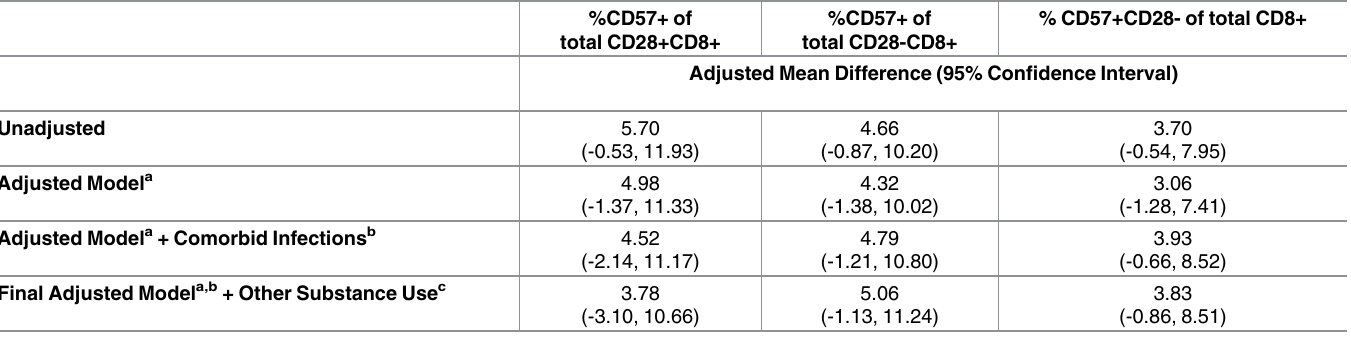
Table 5. Association between illicit opioid use and CD8 T cell senescence, linear regression models.